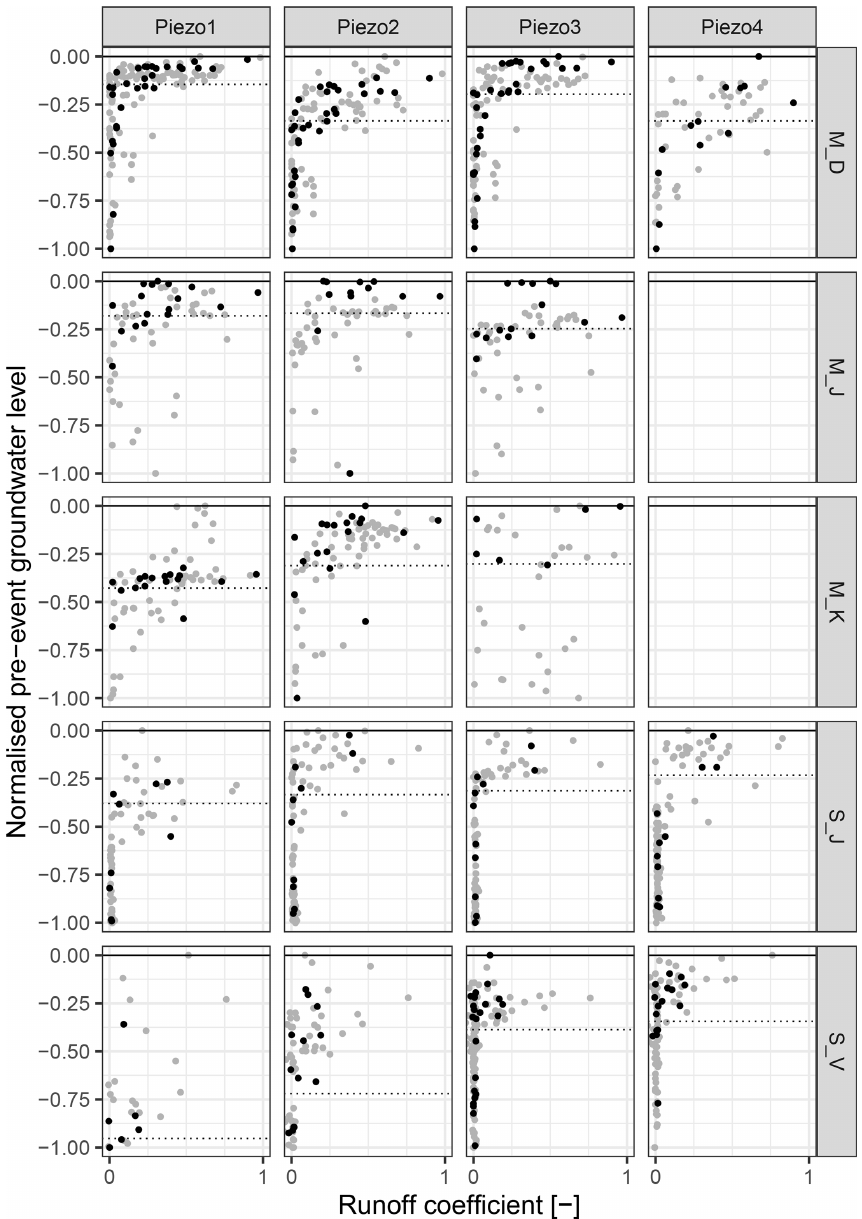
Figure B4. Event runoff coefficients versus shallow groundwater levels. Black events are from 2015, while grey events are from all other years. (Replotting of Fig. 11 to visualize the effect of a reduced (1-year) observation